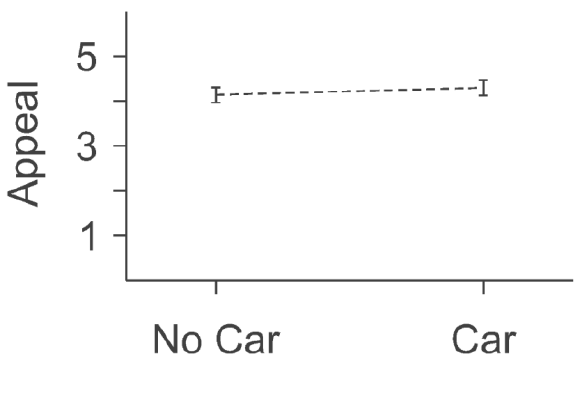
Figure 7. Results for car vs . no car. Solid lines indicate contrasts that achieved the individual “ p < 0.05” level of significance. Dotted lines indicate contrasts that did not achieve the individual “ p < 0.05” level of